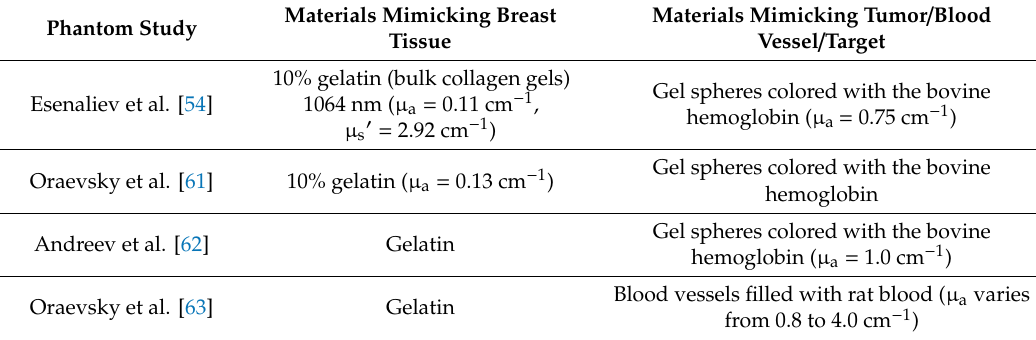
Table 3. Details of materials used for breast tissue, tumor and blood vessels in phantom studies. Phantom